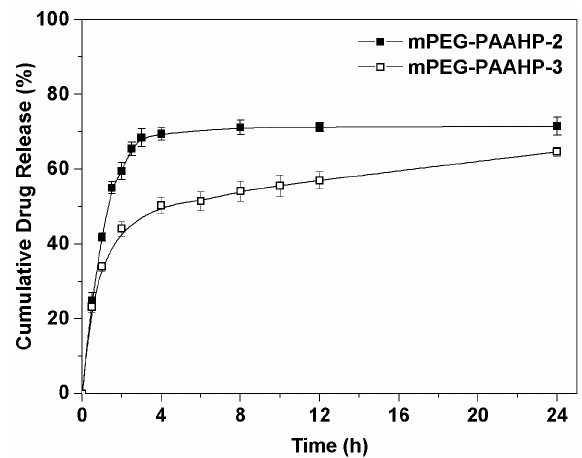
Figure 6. In vitro release profiles of mPEG-PAAHP-2 based nanoparticles containing 4.5% PTX (closed square) and mPEG-PAAHP-3 based nanoparticles containing 9.9% PTX (open square) at 37 ◦ C in PBS (pH = 7.4). Error bars are standard deviations of three measurements.